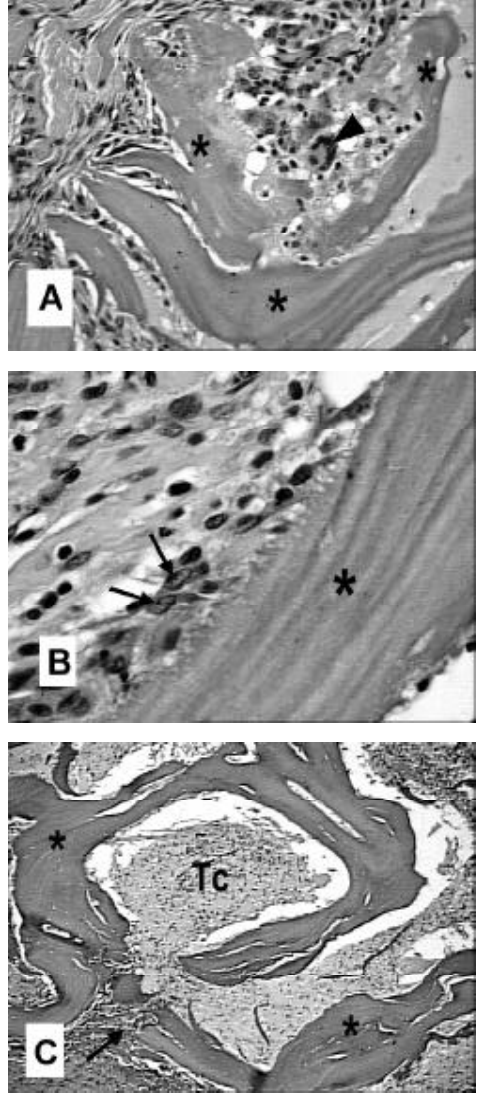
FIGURA 3 - Fotomicrografia do período de 14 dias: A) Células gigantes (cabeça de seta) em contato com o material (*), HE, 96x; B) Células mononucleadas (setas) ao redor do enxerto, HE, 384x; C) Vista geral do material (*), nota-se a migração (seta) do tecido conjuntivo (Tc) para o interior do mesmo, HE, 38x.